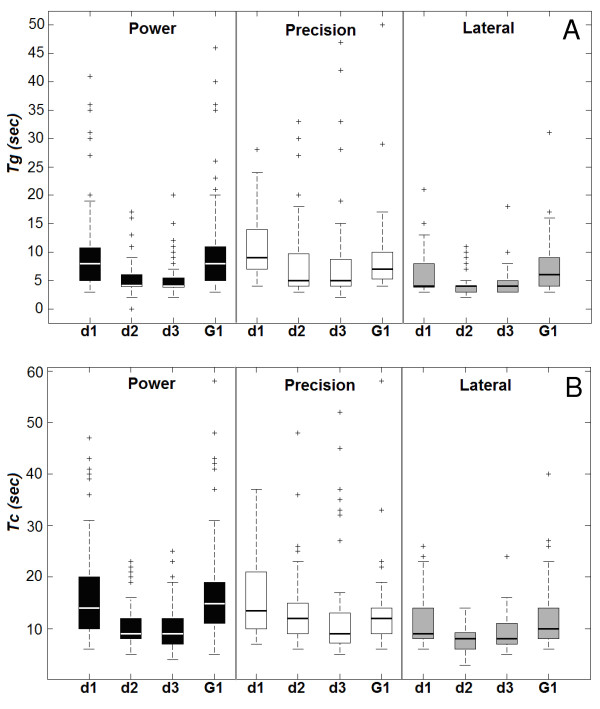
Results: object-grasp and task-completion times distributions. Box & whiskers plots representing (A) object-grasp time (Tg) and (B) task-completion time (Tc) distributions for subjects in G2 on day 1,2,3 (d1, d2, d3) and for group G1. Black boxes refer to power grasps, white boxes to precision grasps and the gray ones to lateral grasps. Each box is delimited by the first and third quartile values; thick horizontal lines, instead, highlight median values. Whiskers show the extent of the rest of the data, while crosses represent the outliers.